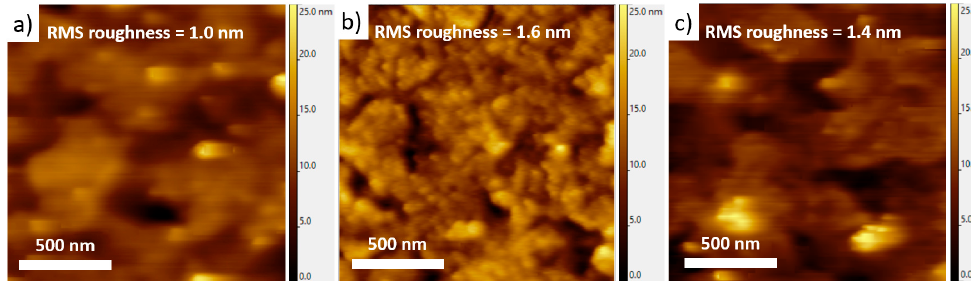
Figure 5. Topographic AFM images of ( a ) bare glass/ITO substrate, and 50 nm thick heptazine layers deposited on glass/ITO by ( b ) vacuum evaporation and ( c ) spin-coating. The corresponding root-mean-square (RMS) roughness values are given in all cases.